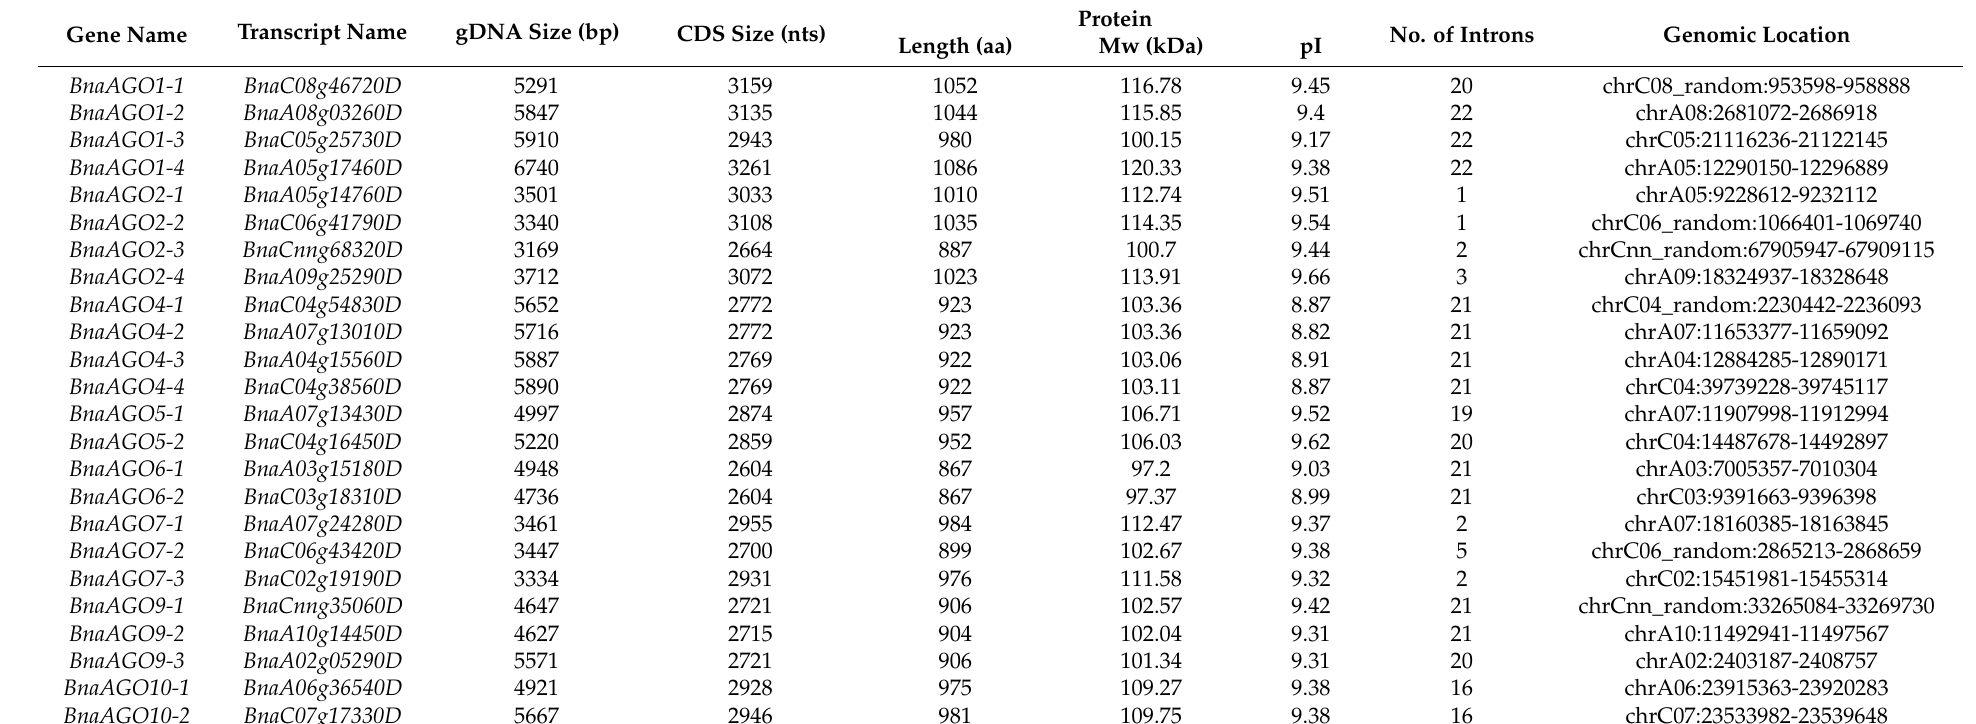
Table 2. Complete list of the 24 BnaAGOs identified in our